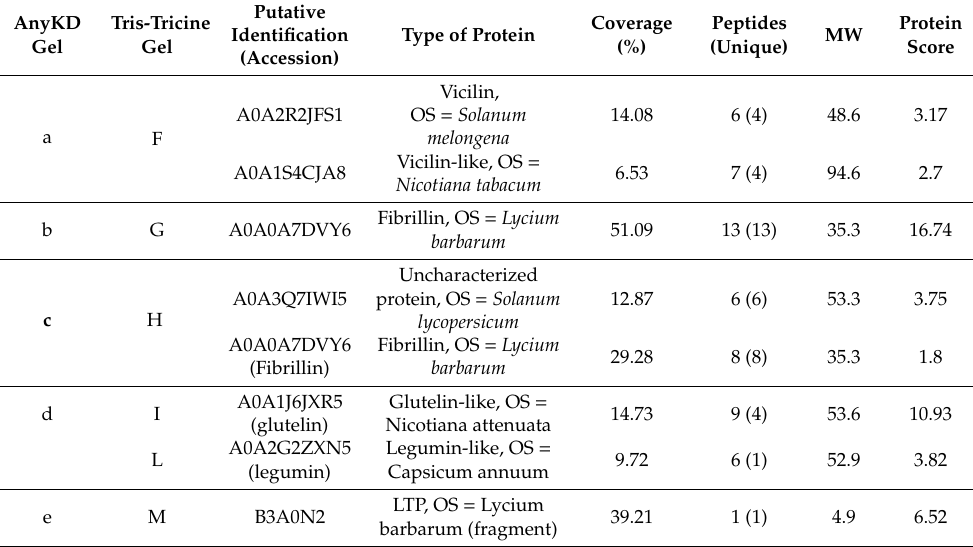
Table 1. Protein identification by LC-HR-MS / MS analysis of excised protein spots from AnykD TM (band a–e) and Tris-tricine gel (bands f–m). In bold are reported the putatively proteins reacting to IgE of allergic